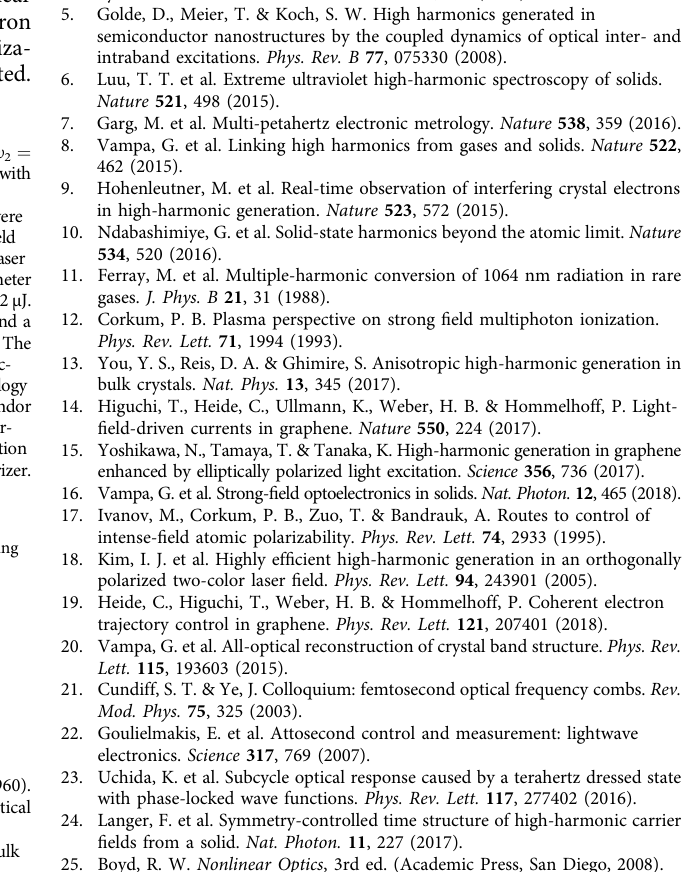
Fig. 5 Numerical simulation based on the time-dependent density matrix method. a Decomposition of the I HH contributions. The gray fi lled region, blue curve, and red curve show the total spectrum, interband, and intraband contributions, respectively, calculated for φ = 15°. b Calculated φ dependence of HH intensities I HH and their intensity ratios for the same order are